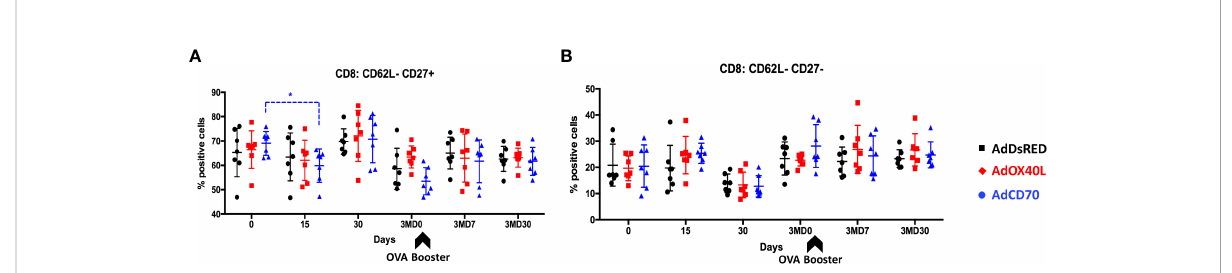
FIGURE 6 AdCD70 administration increases CD8 + T effector cells at day 15 post-inoculation. AdDsRed, AdOX40L or AdCD70 were administered at the time of immunization with OVA in three different groups of sheep. PBMC were obtained at different timepoints: day 0 (immunization), D15, D30, 3MD0 (prior to booster inoculation with OVA), 3MD7 (i.e. 7 days post-booster), and 3MD30 (i.e. 30 days post-booster); and percentages of (A) CD8 + : CD62L - CD27 + and (B) CD8 + : CD62L - CD27 - cells in PBMC evaluated by fl ow cytometry. Arrowheads denote OVA booster inoculations at day 90 (3MD0). * p < 0.05; (two-way ANOVA with Dunnett ’ s post